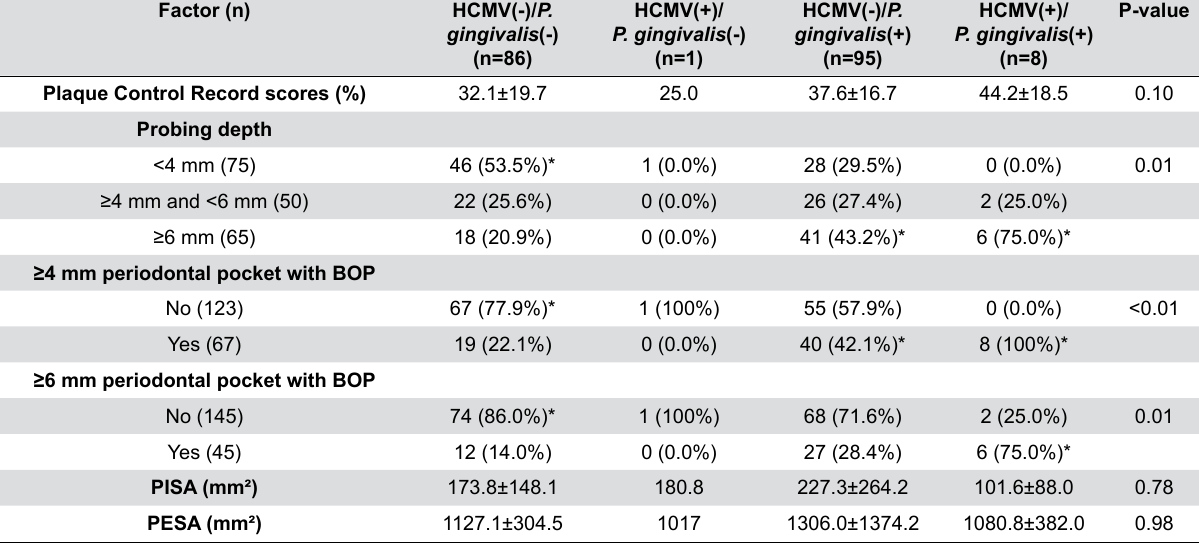
Table 3- Associations of oral HCMV/ P. gingivalis with periodontal